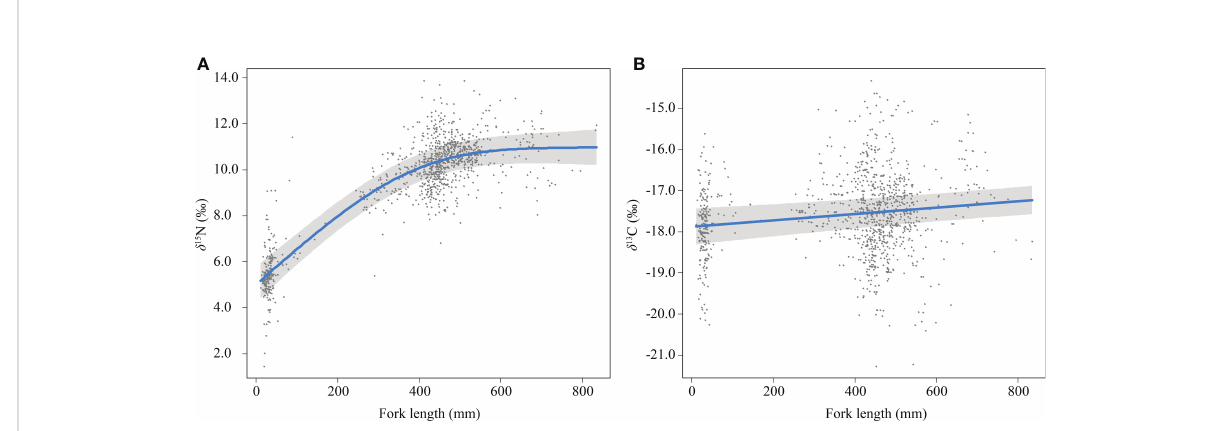
FIGURE 3 Relationship between fork length and d 15 N Bulk (A) and d 13 C Bulk (B) of skipjack tuna ( Katsuwonus pelamis ) in the western Paci fi c (blue lines) with randomized quantile partial residuals (gray areas) from the best- fi t models. Each data point represents residuals from each data.